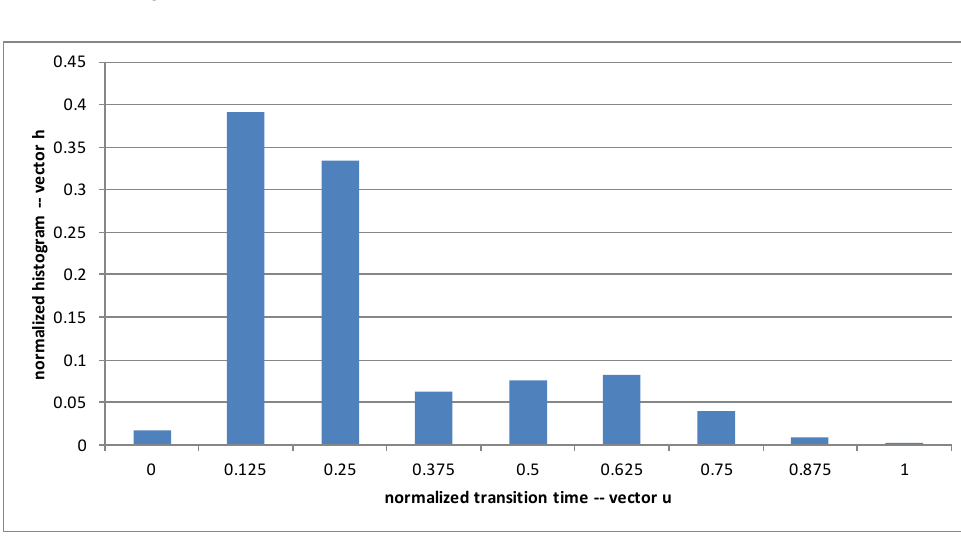
Figure 9. Normalized histogram h of transition time. In order to use the normalized histogram in the modified particle swarm optimization, its values should be interpolated (see Figure 10). Interpolation operation is